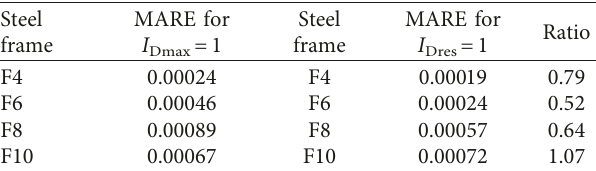
Figure 7: Comparison of the I Dres hazard curves for the MRSFs and the PTC steel frames with (a) 4 stories, (b) 6 stories, (c) 8 stories, and (d) 10 stories. Table 3: Mean annual rate of exceedance values when the damage index is equal to one in terms of I Dmax for the MRSFs and in terms of I Dres for the PTC steel